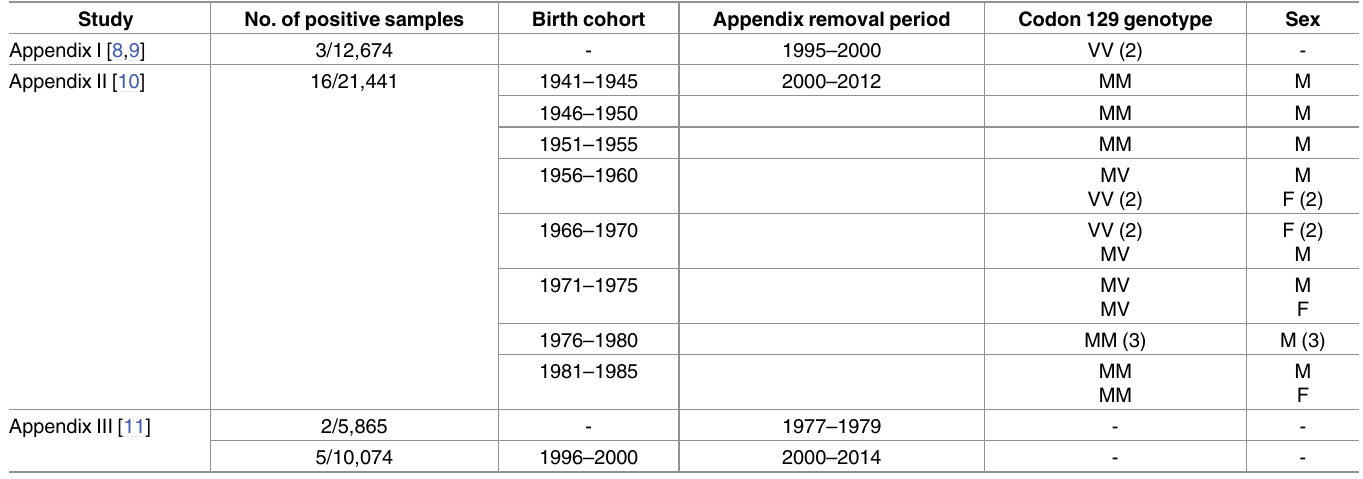
Table 2. Summaryof the appendix survey